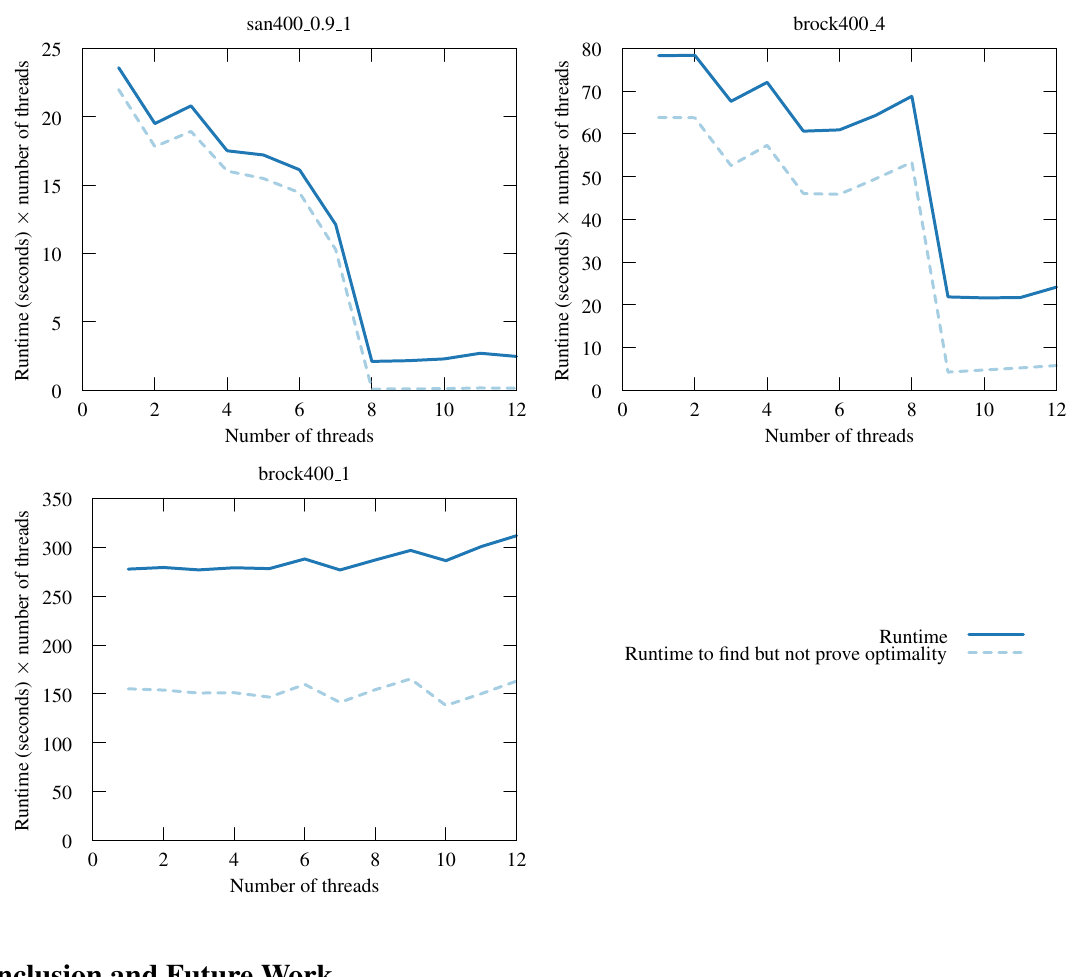
Figure 3. Total CPU time spent ( i.e. , runtimes multiplied by the number of threads) for “san400 0.9 1” from DIMACS with varying numbers of threads. Also shown is the total CPU time taken to find a maximum clique, but not to prove its optimality. A linear speedup would give a horizontal line, and downwards sloping lines are